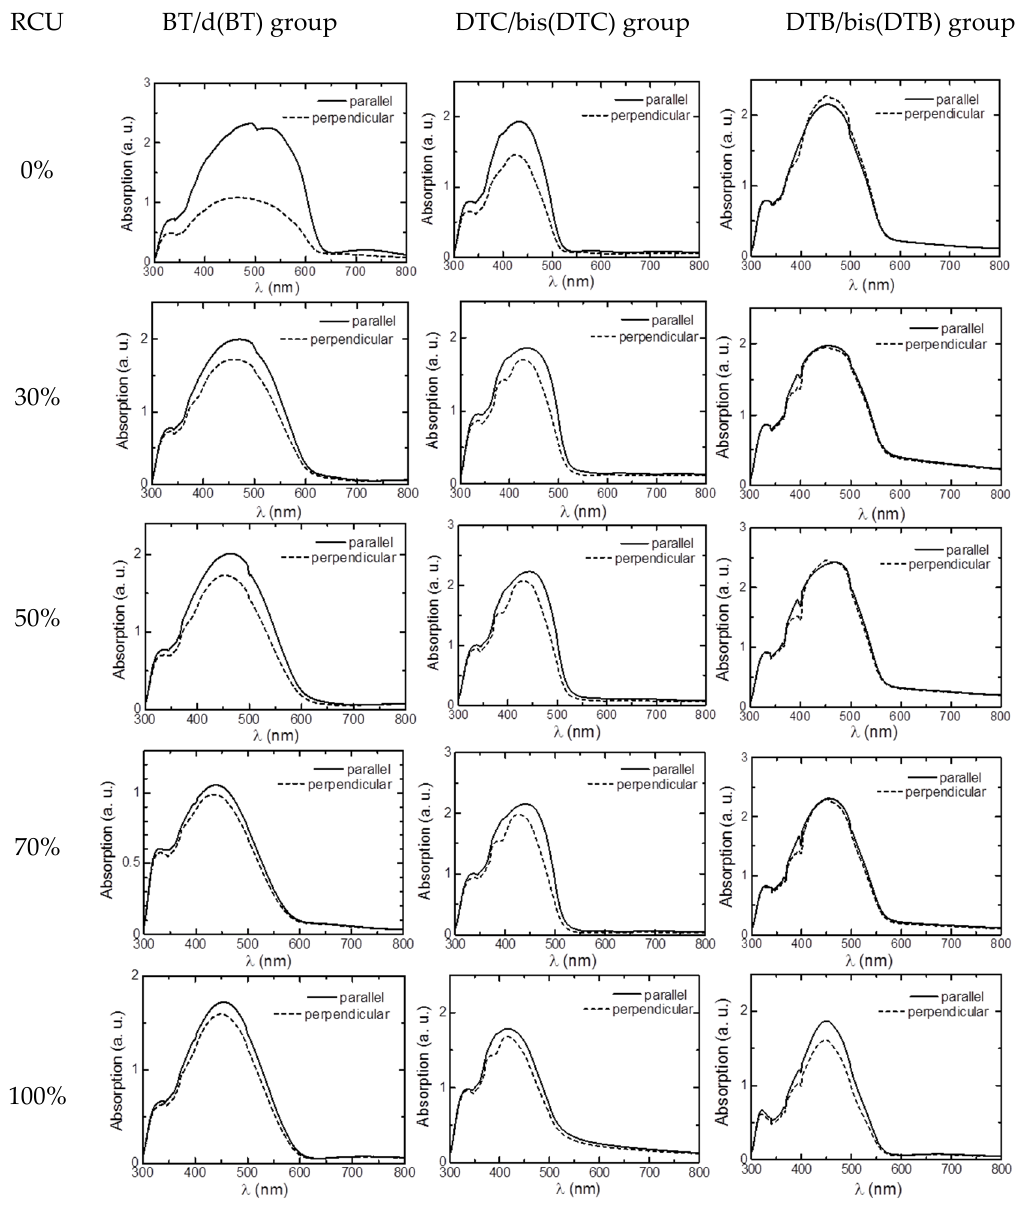
Figure 4. Linear dichroism (LD) UV–vis absorption spectra of polymer films obtained from the BT/d(BT) group, DTC/bis(DTC) group, and DTB/bis(DTB) group with different RCUs. In each spectrum, the solid line indicates the absorption intensity along the direction parallel to the liquid crystal orientation; the dashed line indicates the absorption intensity along the direction perpendicular to the liquid crystal orientation. LD: Linear dichroism. LDR: Linear dichroism ratio. RCU: Ratio of crosslinked units.